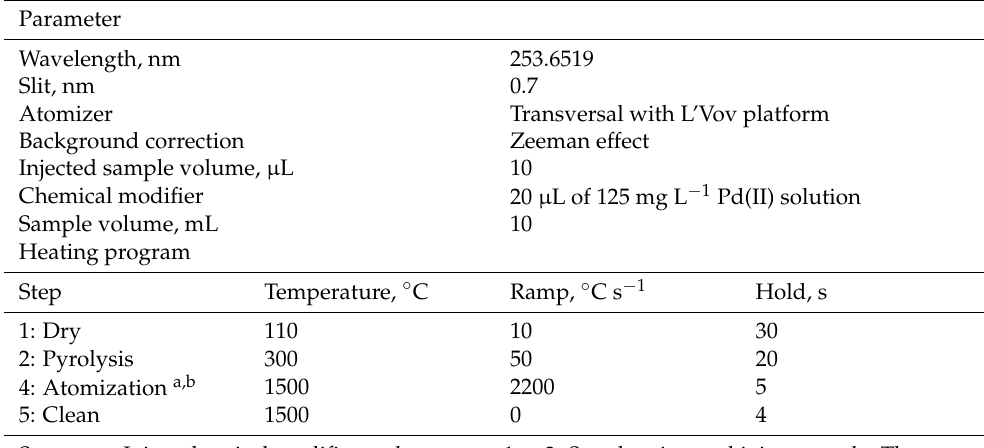
Table 1. Instrumental parameters and heating program for mercury